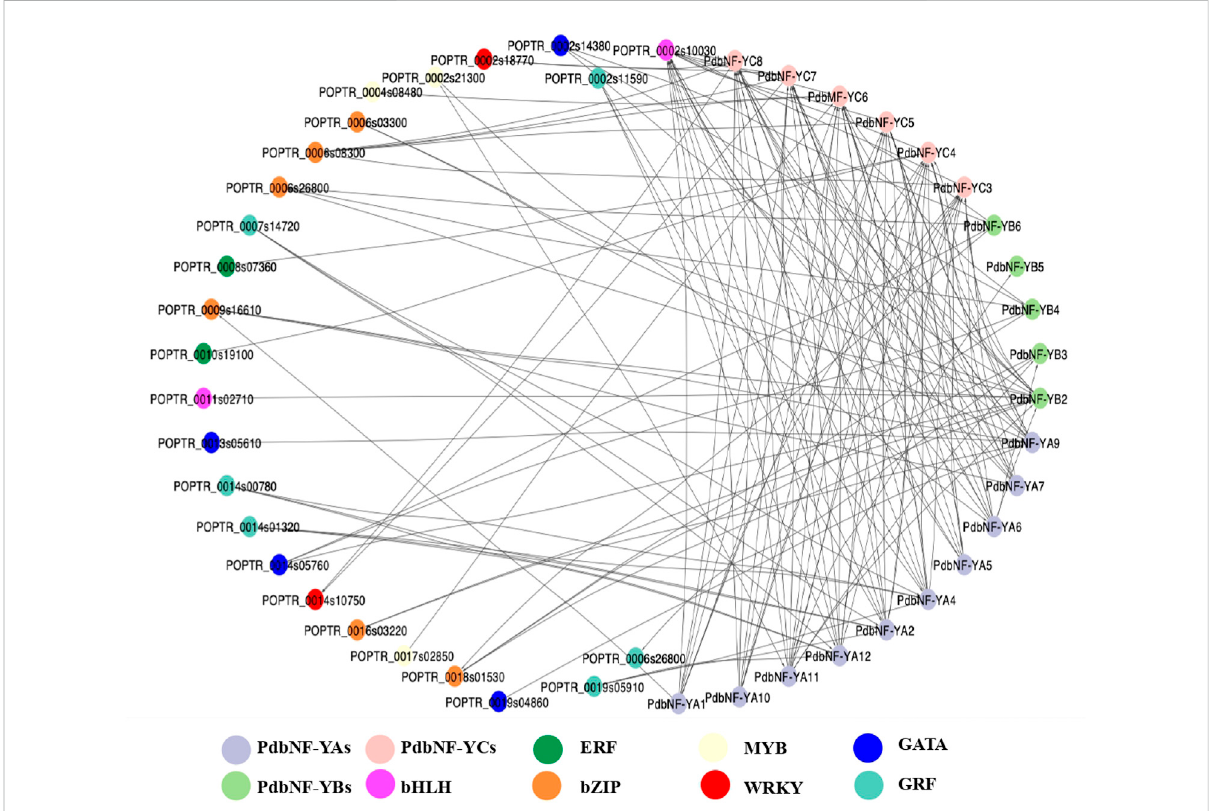
FIGURE 5 Protein – protein interaction analysis of PdbNF-Ys and other transcription factors. Protein – protein interaction network of PdbNF-Ys and other transcription factors. Colored circles indicate different transcription factors (TFs).